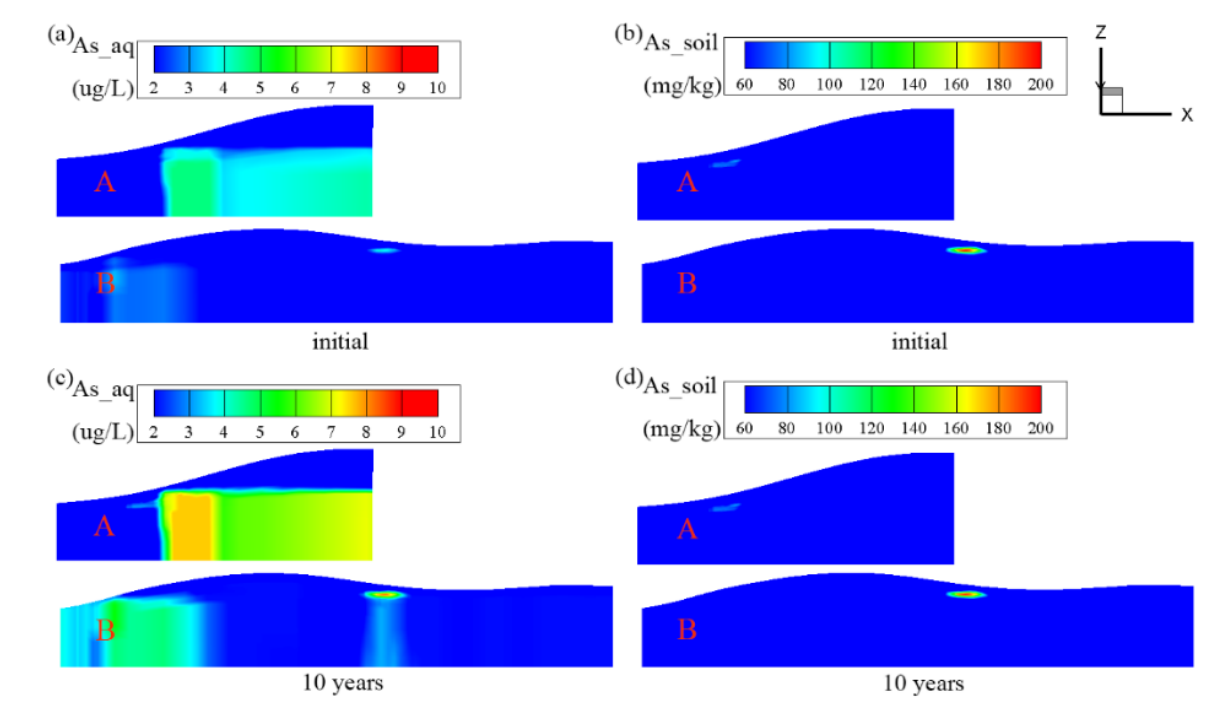
Figure 4. Initial distributions of As concentration in groundwater ( a ) and in soil ( b ), The simulated distributions of As concentrations in groundwater ( c ) and in soil ( d ) after 10 years of the partial excavation of highly contaminated soil (scenario 1). Here, As_aq and As_soil represented groundwater arsenic concentration, soil arsenic concentration, respectively.